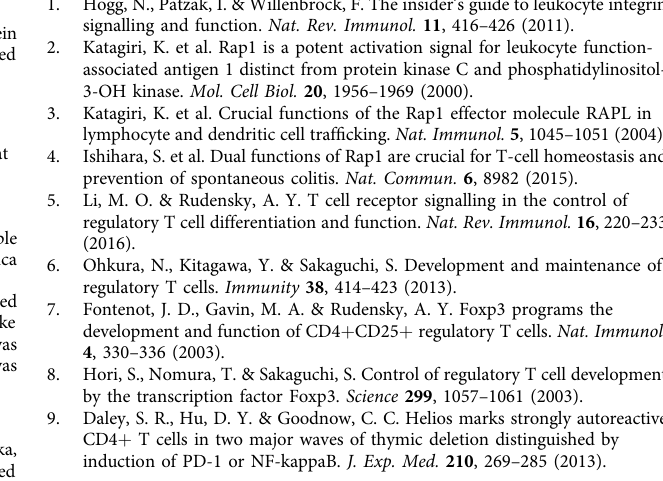
Fig. 7 Rap1 was involved in the formation of actin foci. a (Left) Defective actin polymerization in Rap1-de fi cient naïve CD4 + cells. WT and Rap1-de fi